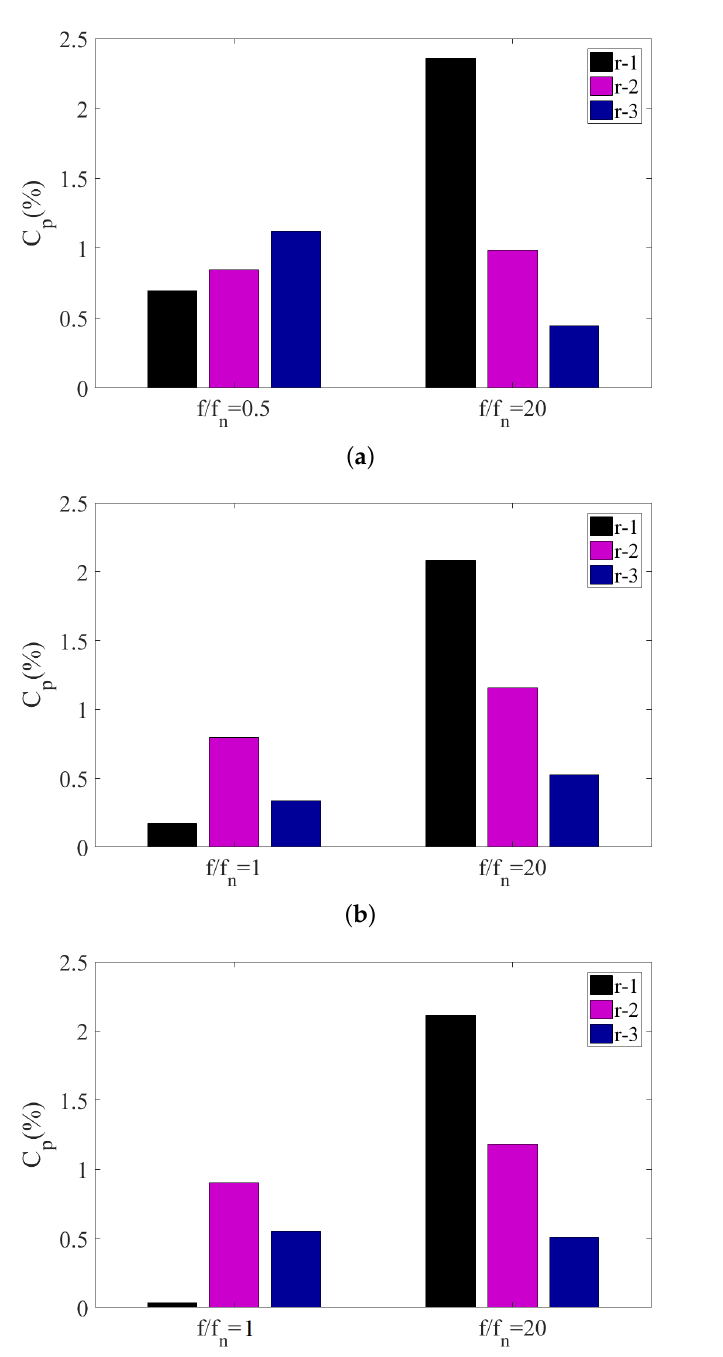
Figure 21. Amplitudes of pressure fluctuations at the monitoring points along the runner passage.